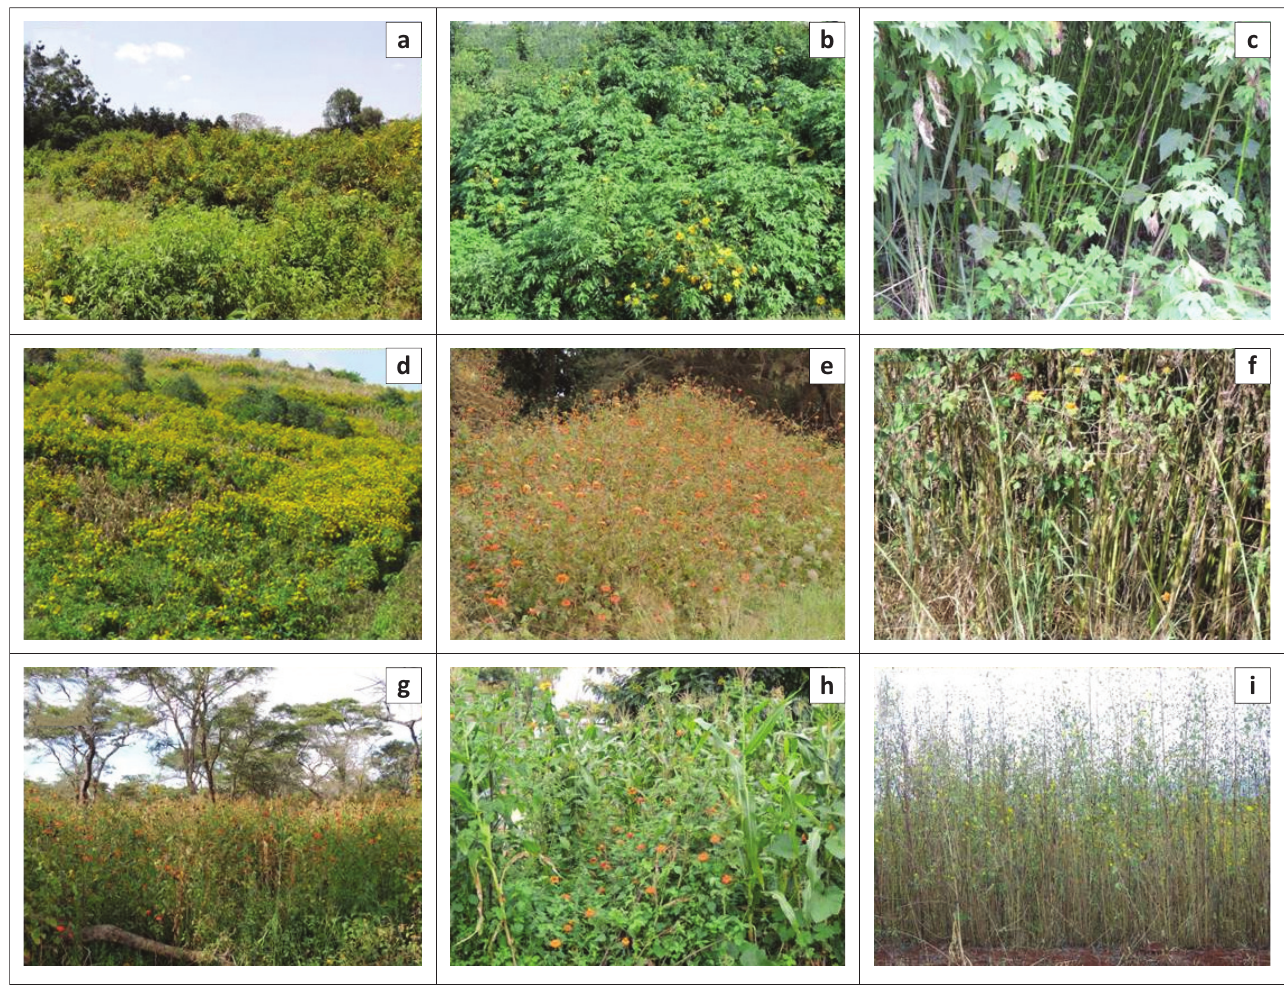
FIGURE 4: (a and b) Tithonia diversifolia invasions in Kenya, (c) T. diversifolia undergrowth in Zomba, Malawi, (d) T. diversifolia invasion in maize field in Malawi, (e) T. rotundifolia invasion in Zambia, (f) T. rotundifolia undergrowth in Zambia, (g and h) T. rotundifolia invasions in maize fields in Zambia and (i) T. tubaeformis invasion in